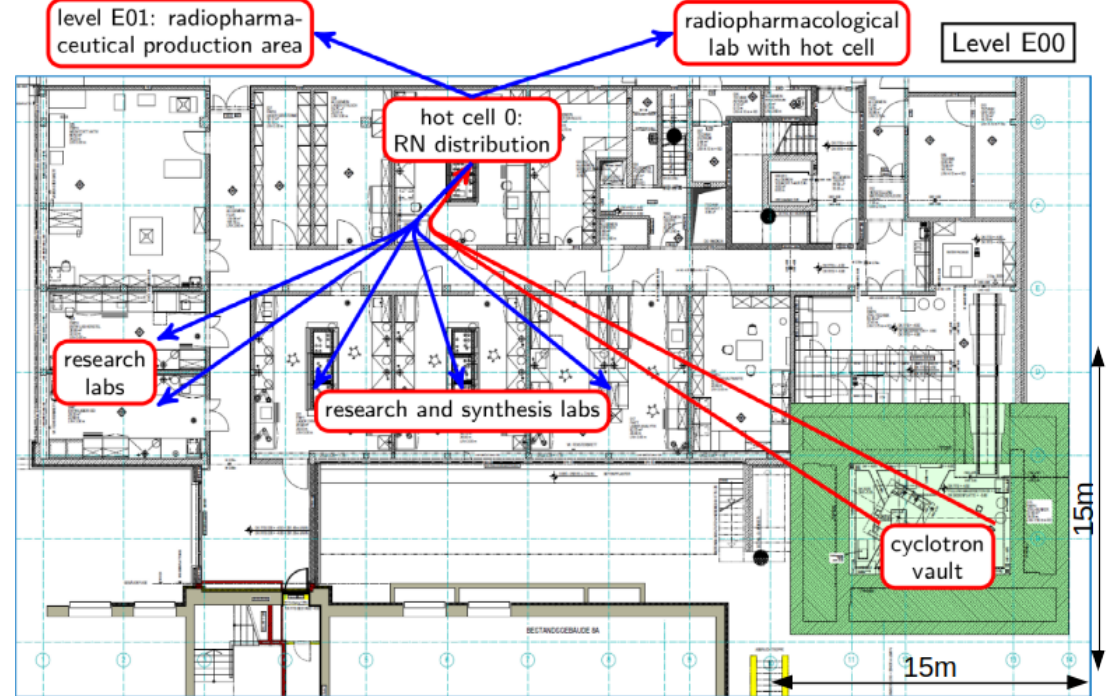
Figure 5. Schematic view of the radionuclide distribution in the building. Red lines: unload the targets to the hot cell “0”; blue lines: radionuclide distribution within the ZRT building.